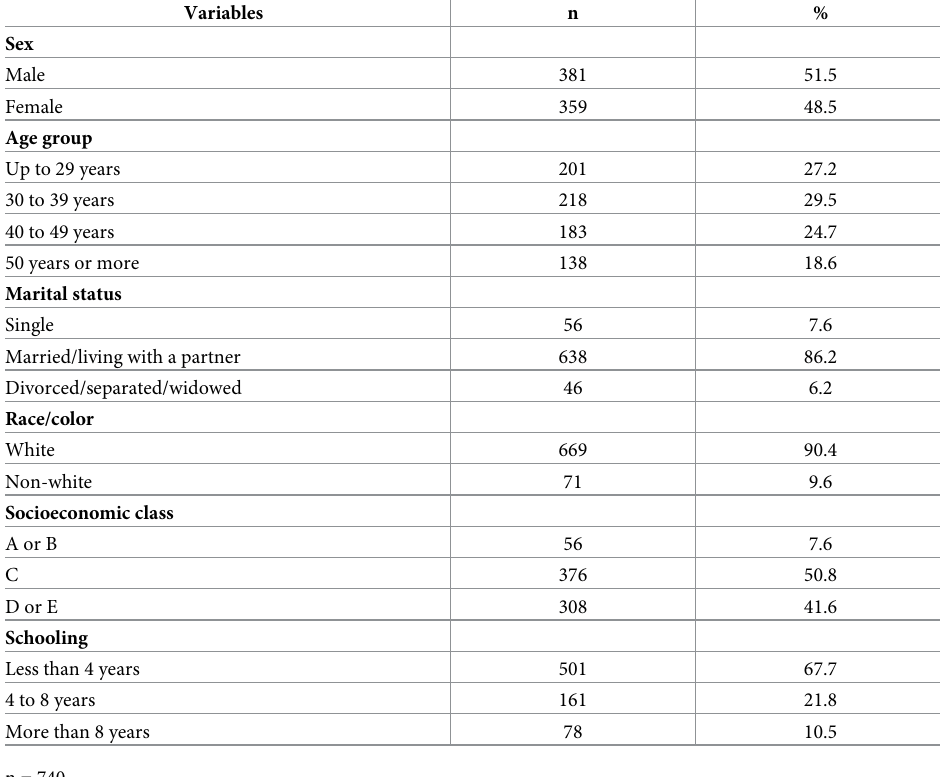
Table 1. General characteristics of study